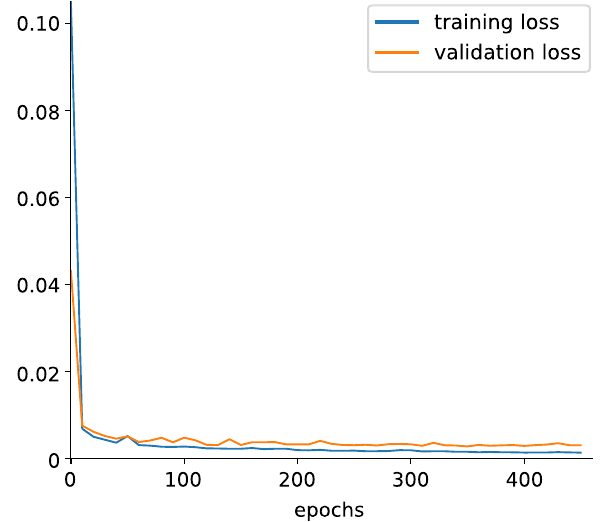
FIG. 2. The training loss (blue) and the validation loss (orange) as a function of the number of training epochs. The design point from Eq. (25) is considered and the functions that are approxi- mated are the five objective functions from Eq. (27), as well as ctfp and adts from Eq. (28) (seven in total). The size of the random sample is 3 × 10 4 and the hyperparameters are: 5 , N 64 and N 128 , with the ReLU N layers ¼ neurons ¼ batch ¼ activation function. The training was stopped once there was no improvement in the validation loss for 100